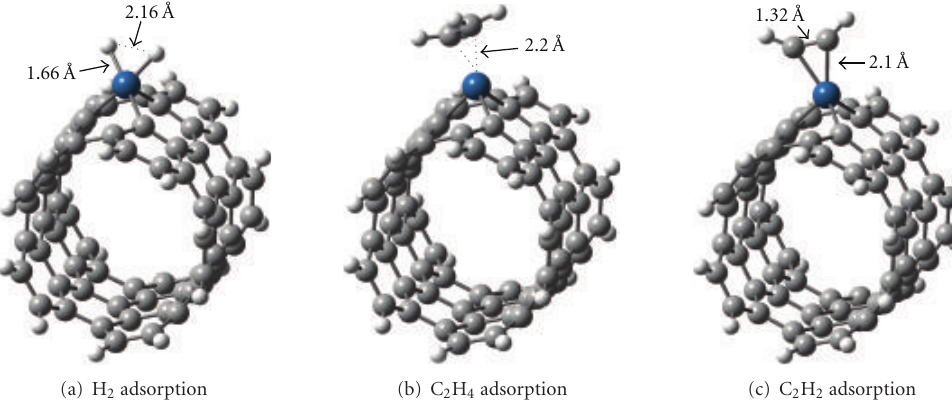
Figure 24: Optimized geometries for side-on adsorbed HSWCNTs [113]. Legend: dark grey = carbon, light grey = hydrogen, blue =